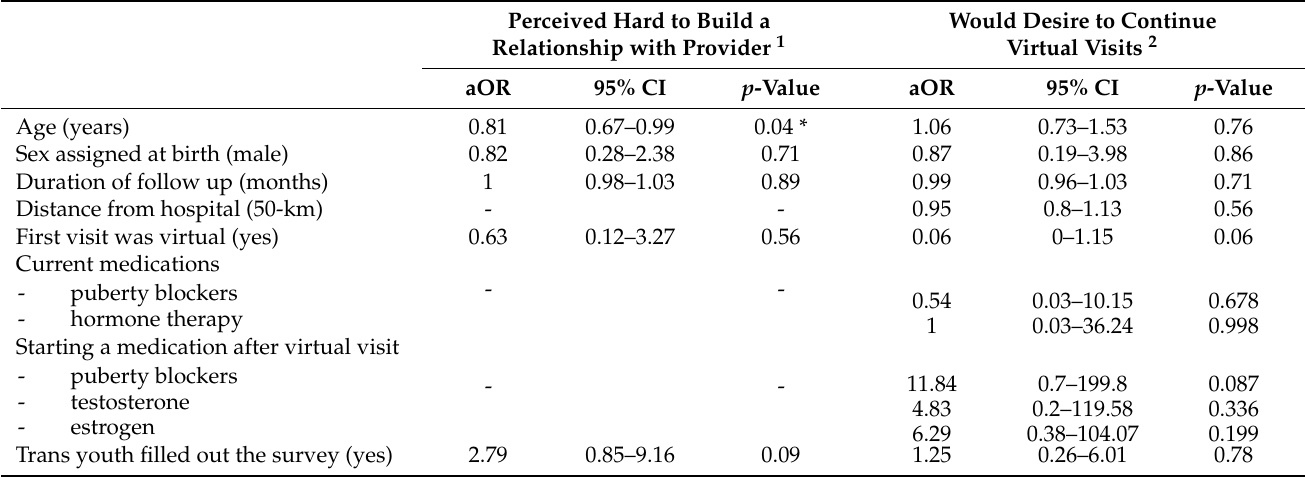
Table 3. Association between patient characteristics and difficulty building a relationship with their provider on a virtual visit and desire to continue virtual care: multivariable regression analysis.